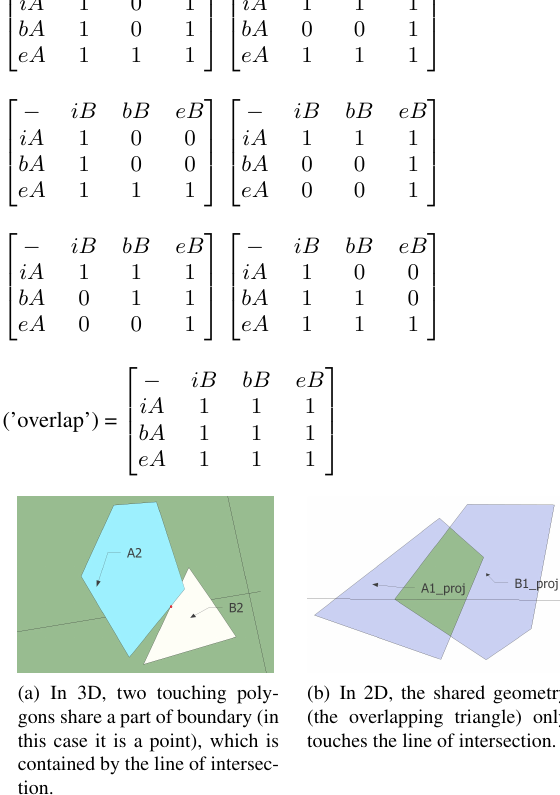
Figure 4: Touching polygons in 3D, their projections in 2D and the line of